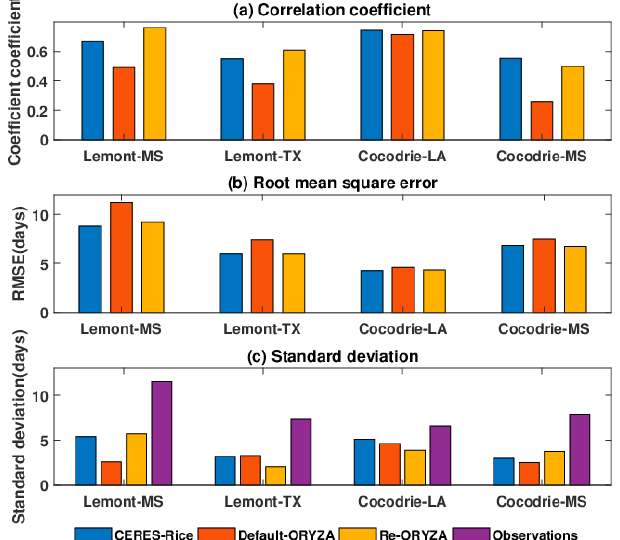
Figure 1. Comparison of ( a ) correlation coefficient, ( b ) root mean square error (RMSE), and ( c ) standard deviation for CERES-Rice and the two ORYZA versions (default and re-parameterized). Correlation coefficient and RMSE were obtained from the difference between observed and simulated values, and standard deviations reflect the annual yield variation for Lemont at Beaumont, TX (1983–1998) and Stoneville, MS (1983–1998), and for Cocodrie at Crowley, LA (2003–2016) and Stoneville, MS (1998–2016).